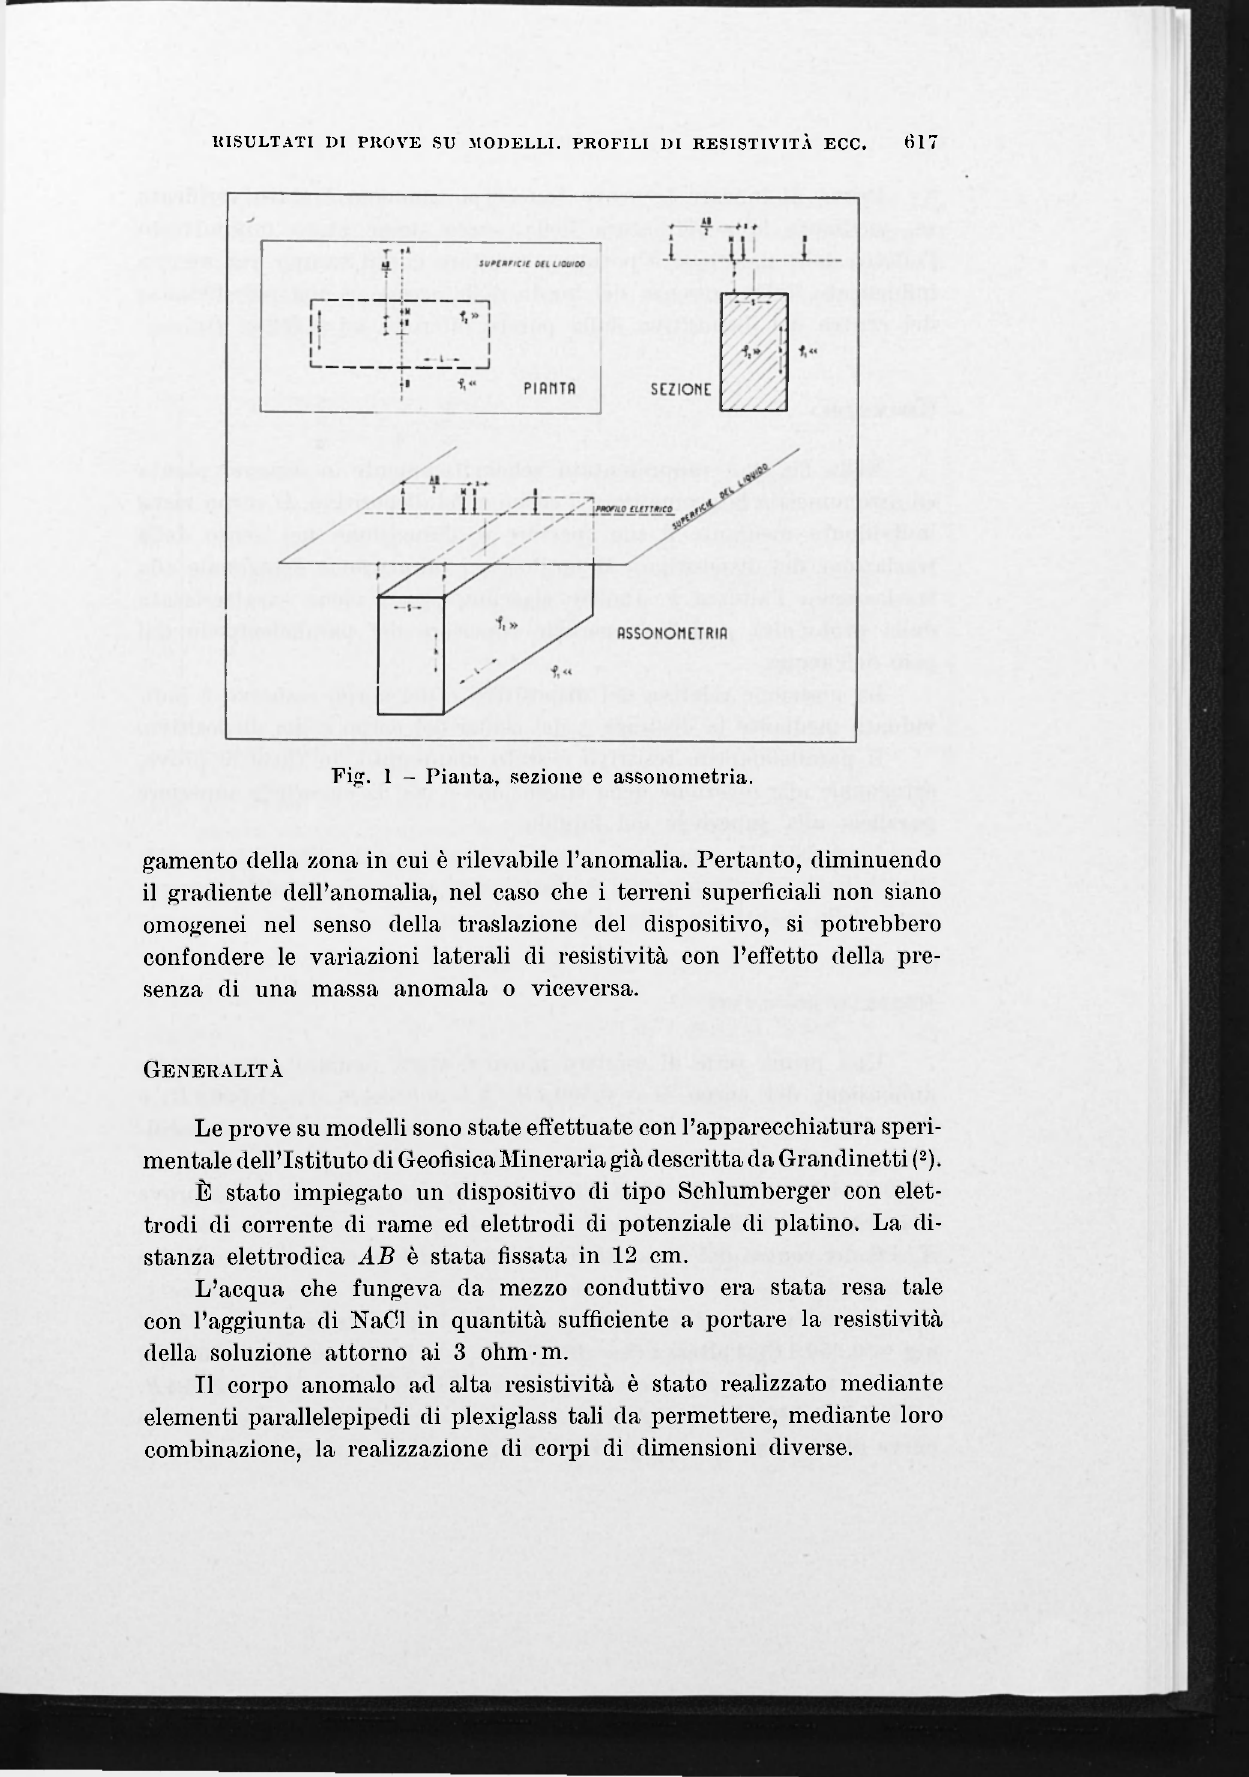
Fig. 1 - Pianta, sezione e